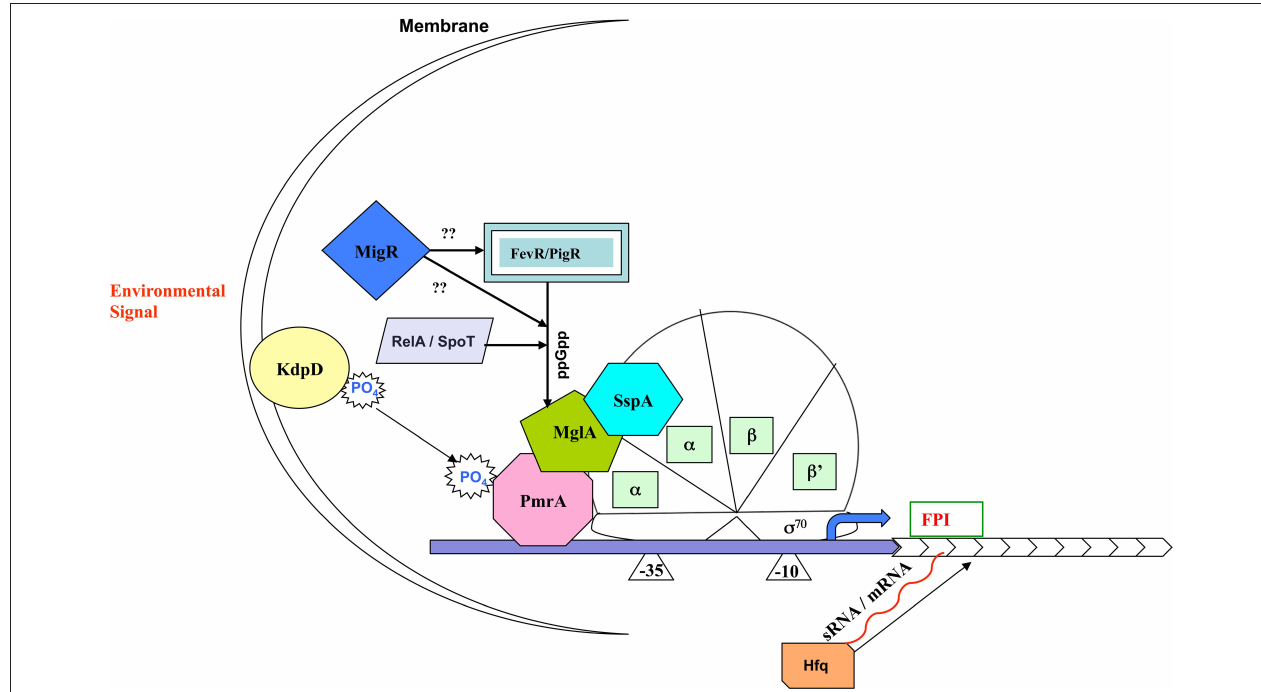
FiGUrE 2 | Model for regulation of Francisella pathogenicity island gene expression. Unknown environmental signals are sensed by KdpD and relayed to the DNA binding protein PmrA. MglA and SspA heterodimerize and associate with RNA polymerase (RNAP). The regulatory activity of the MglA/SspA/RNAP complex is dependent on association of PmrA to the complex as well as the production of ppGpp, which promotes interaction of FevR / PigR with the MglA/SspA/RNAP